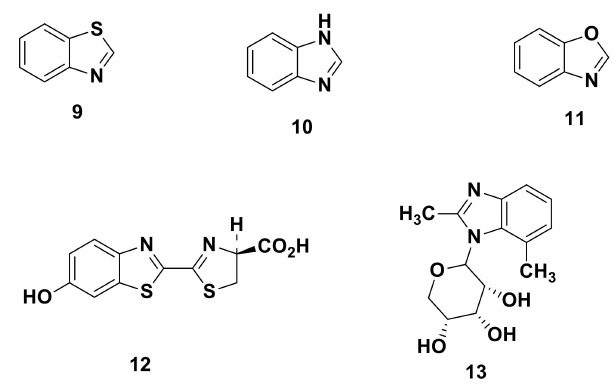
Figure 6. Benzazole core in some